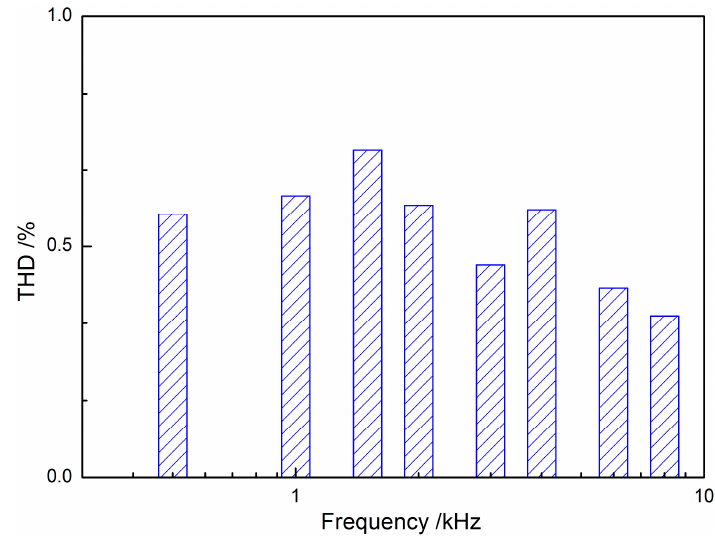
Figure 7. Histogram of the transducer’s total harmonic distortion (THD).